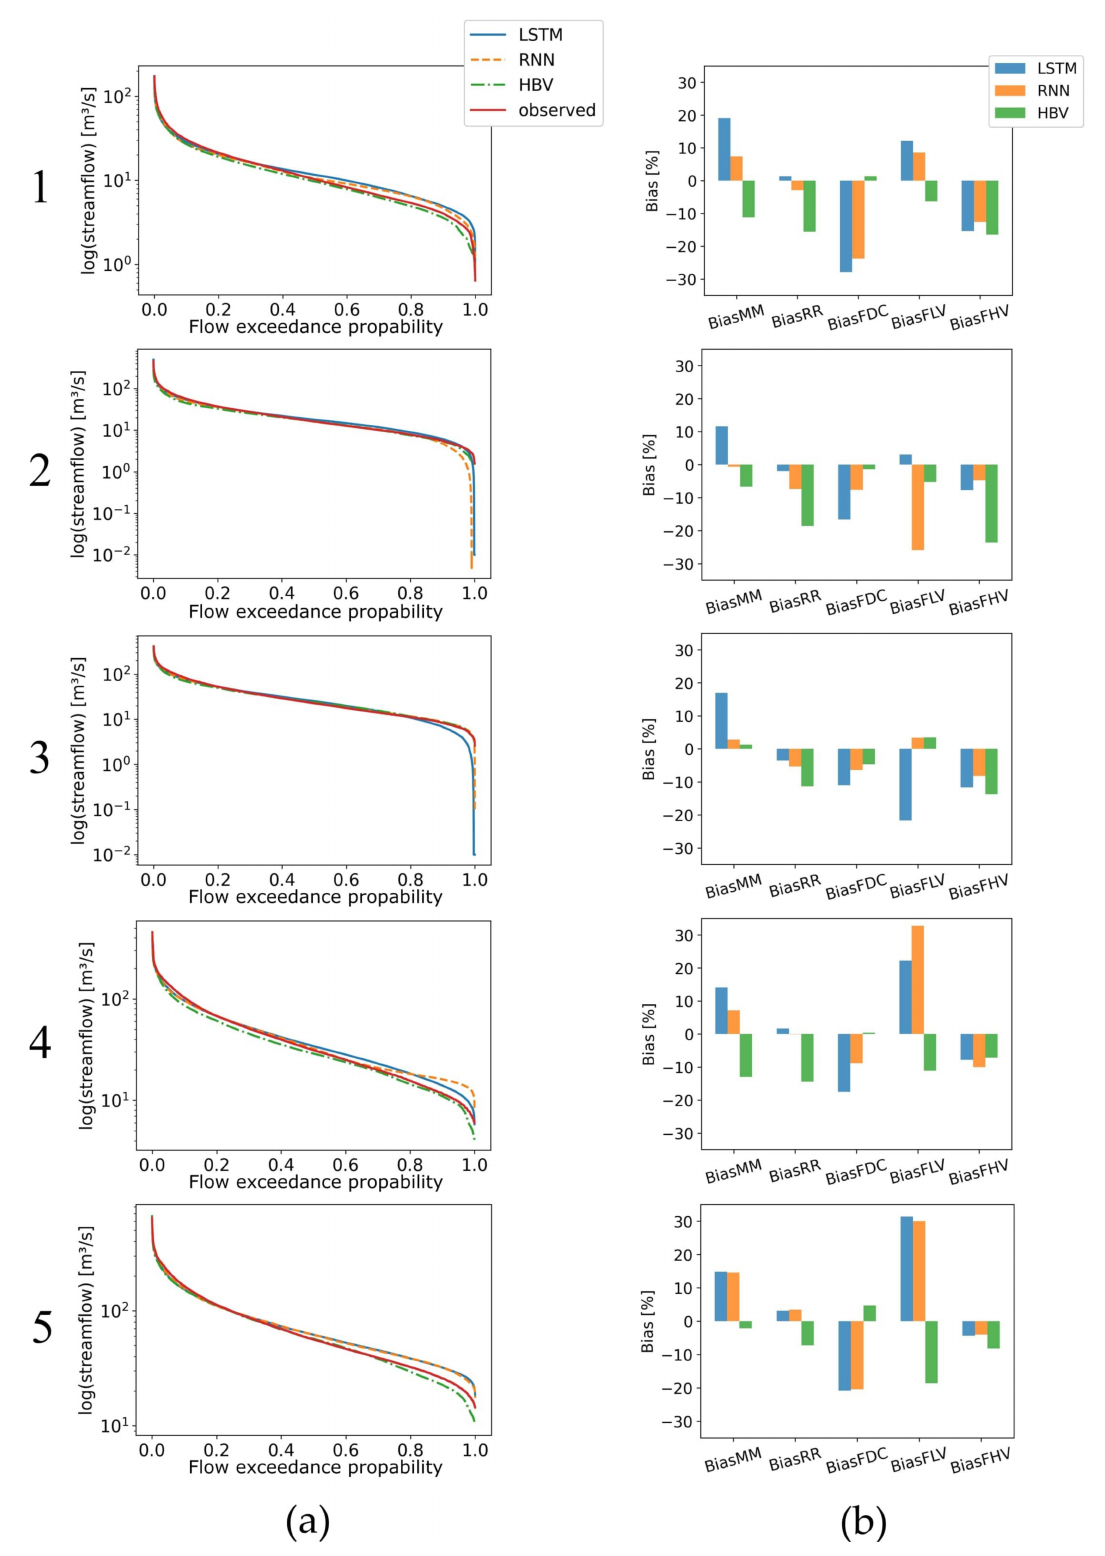
Figure 7. ( a ) Flow duration curves of all three model types and observed streamflow. ( b ) Bias of the five signature indices for the three model types compared to the observed